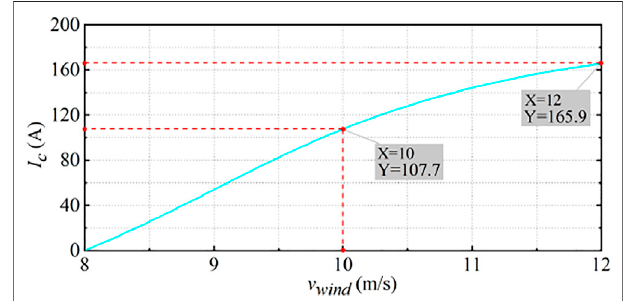
FIGURE 15 | Capacitor voltage under the traditional method.